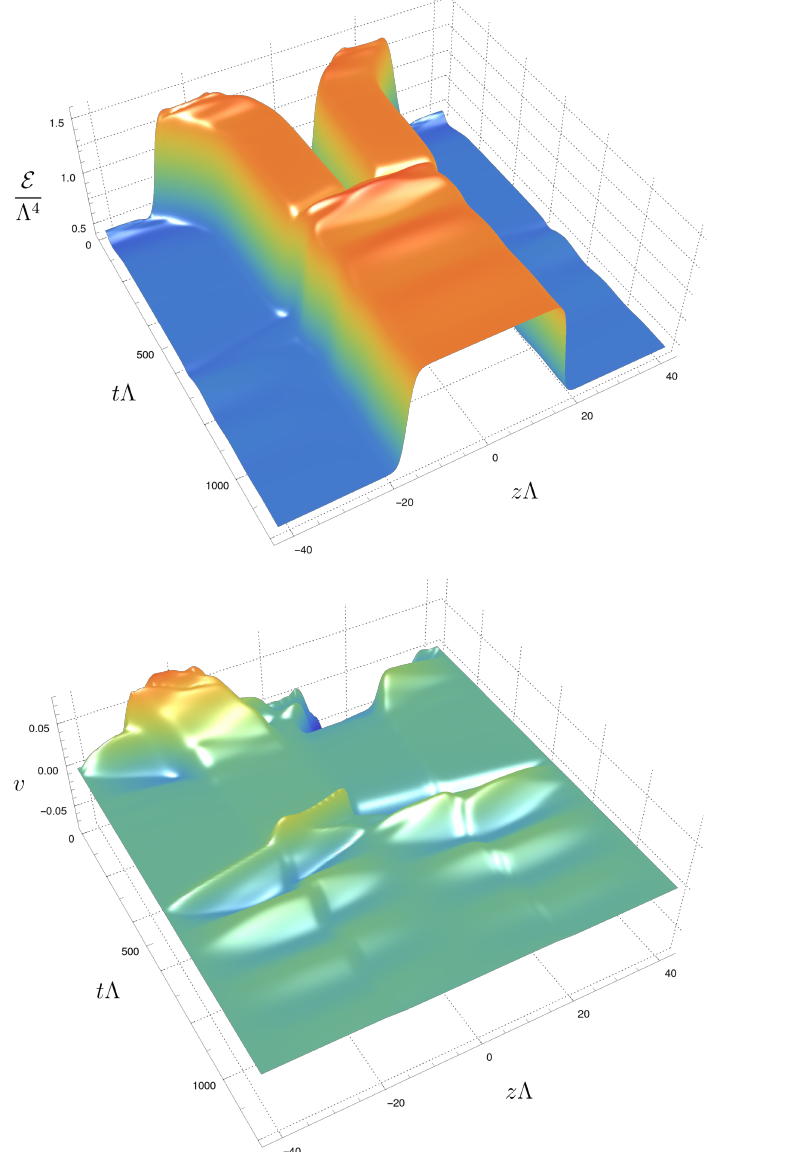
Figure 9 . Evolution of the energy density (top) and of the fluid velocity (bottom) for a simulation with v max = 0 . 08